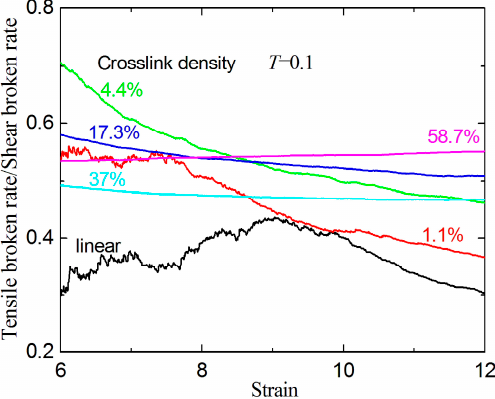
Figure 11. The tensile broken ratio/shear broken ratio with different crosslink densities at T = 0.1.